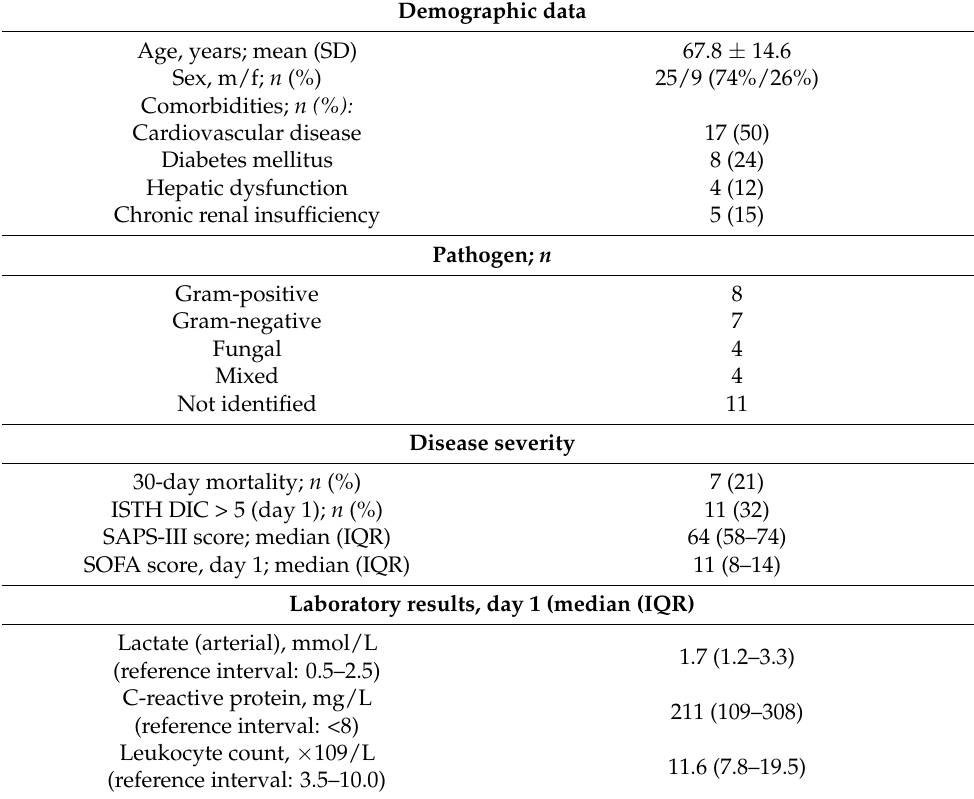
Table 1. Demographic and clinical characteristics of septic shock patients ( n = 34).